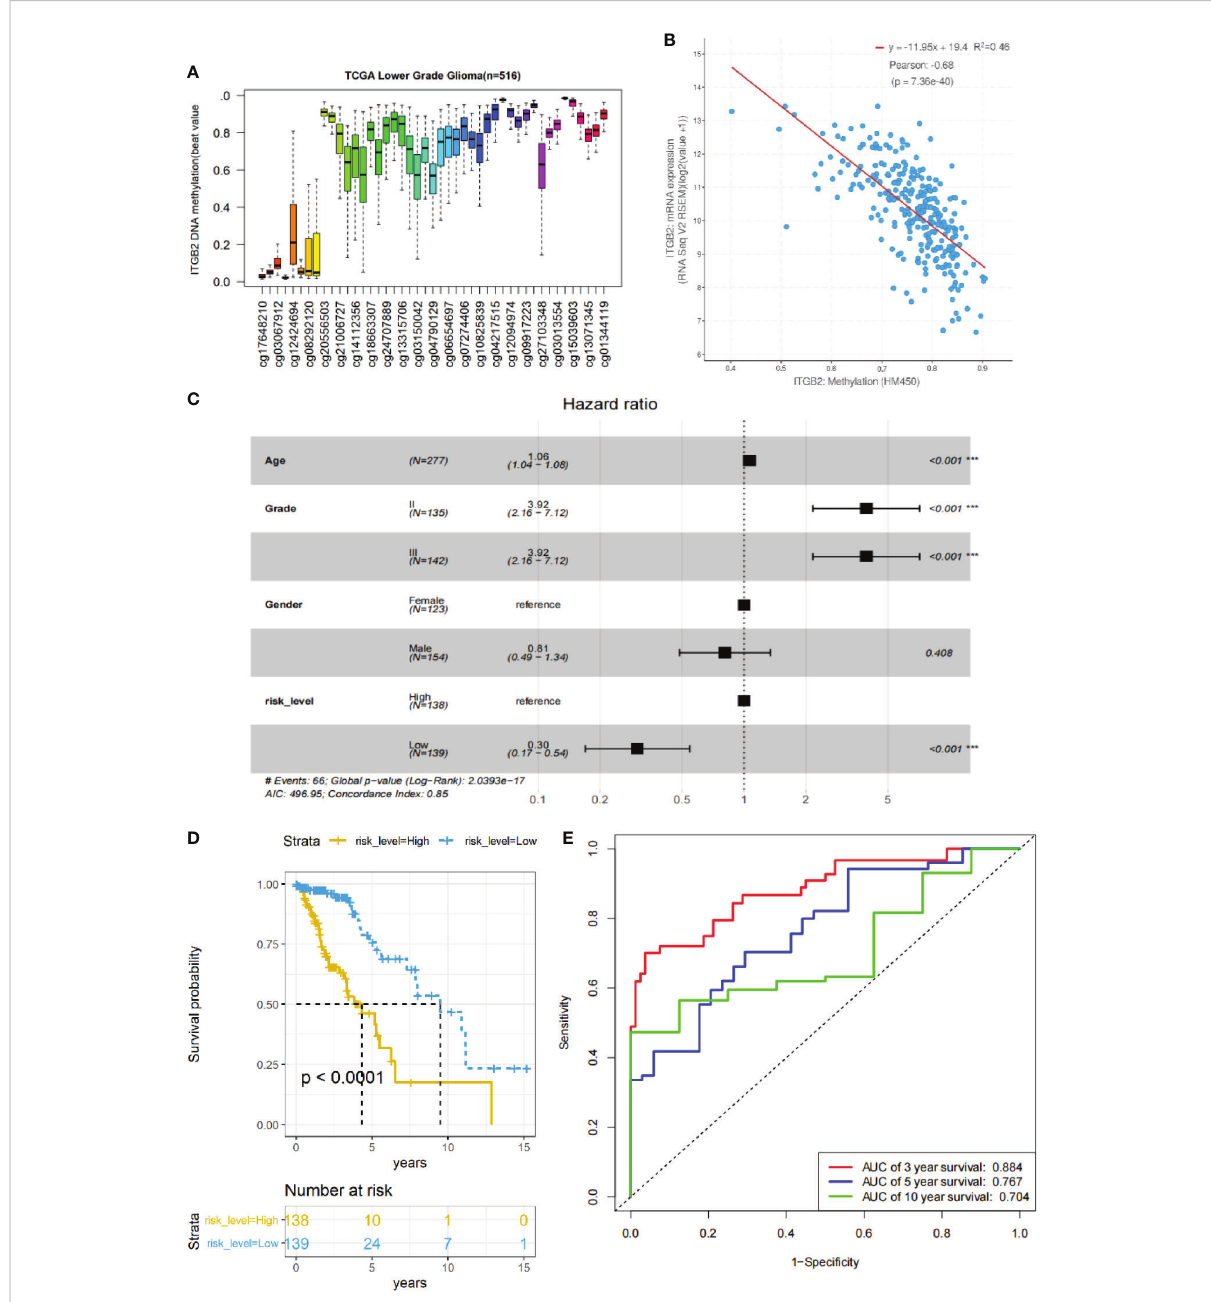
FIGURE 7 The relationship between ITGB2 expression and methylation in LGG tissues revealed by bioinformatic analysis. (A) The distribution of 45 ITGB2 DNA promoter CpG sites. (B) The expression of ITGB2 was negatively regulated by ITGB2 DNA methylation. (C) Forest plot of low ITMRS can be used as an independent risk factor in LGG patients from the TCGA-LGG dataset (P < 0.001). (D) survival analysis of LGG patients with a high ITMRS (ITMRS High) versus low ITMRS (ITMRS Low) in the TCGA LGG datasets. The P value was determined by the chi-square test between the two groups. (E) ROC curves of the prediction of 3-year survival 、 5-year survival 、 10-year survival with ITMRS in the TCGA LGG datasets.Risk level high and low represent ITMRS high and low. ***p <